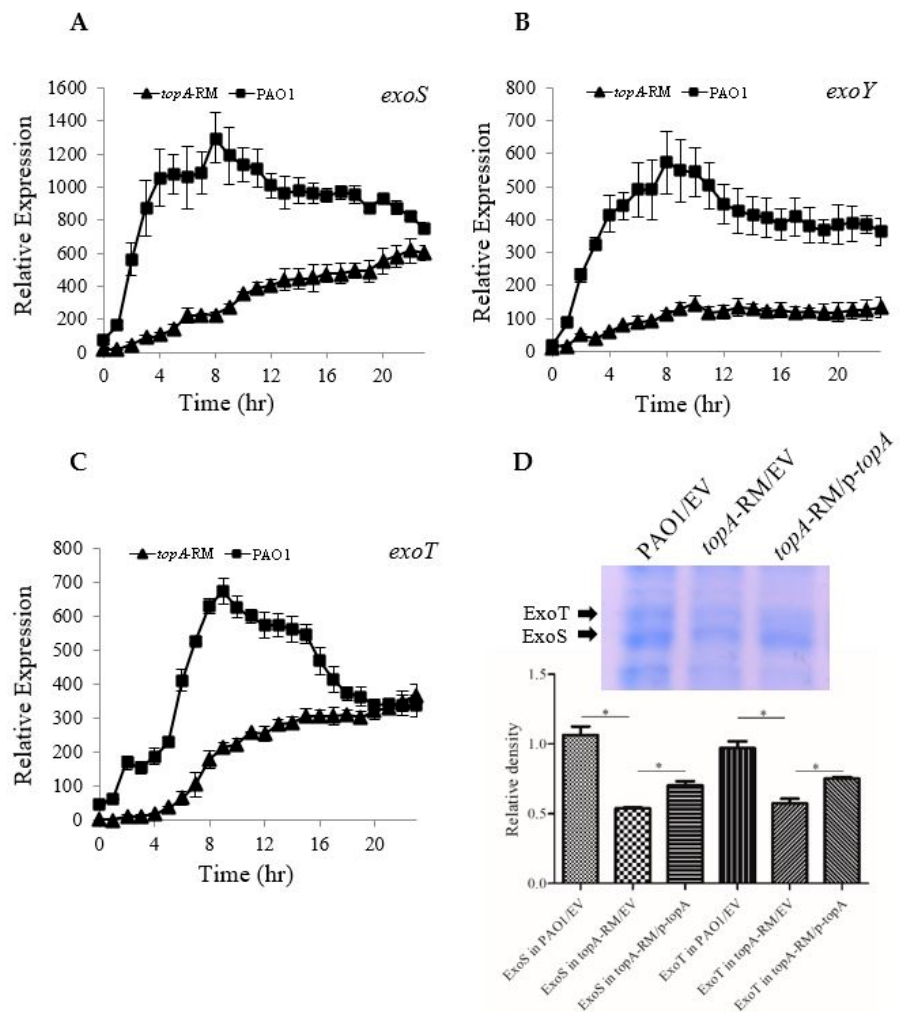
Figure 2. Reduced expression of T3SS effectors in topA -RM. ( A–C ) The expression profiles of T3SS effectors measured using p- lux promoter-reporter system. The values are presented as cps normalized to OD 595 . The values of topA -RM are shown as triangles and those in PAO1 as squares (data shown as averages from triplicate experiments ± standard errors of the means). ( D ) Effect of altered TopA on T3SS effectors protein secretion. A representative gel image is shown on top and the quantitative values (mean and SD) of ExoS and ExoT calculated from the results of three repeats are shown underneath. Proteins in the culture supernatants of various strains grown in T3SS-inducing condition were precipitated by TCA and analyzed by SDS-PAGE, followed by staining with Coomassie blue. The relative quantification of the secreted ExoS protein on the gel was evaluated by the relative density of the bands using the GeneTools software (Syngene, Cambridge, United Kingdom). Two-tailed unpaired t -test was performed using GraphPad software version 5.0 (*, P < 0.05). ExoT and ExoS are indicated by solid arrows, as established in previous reports [28,31]. EV: empty vector as a control. p- topA : topA complementation construct.